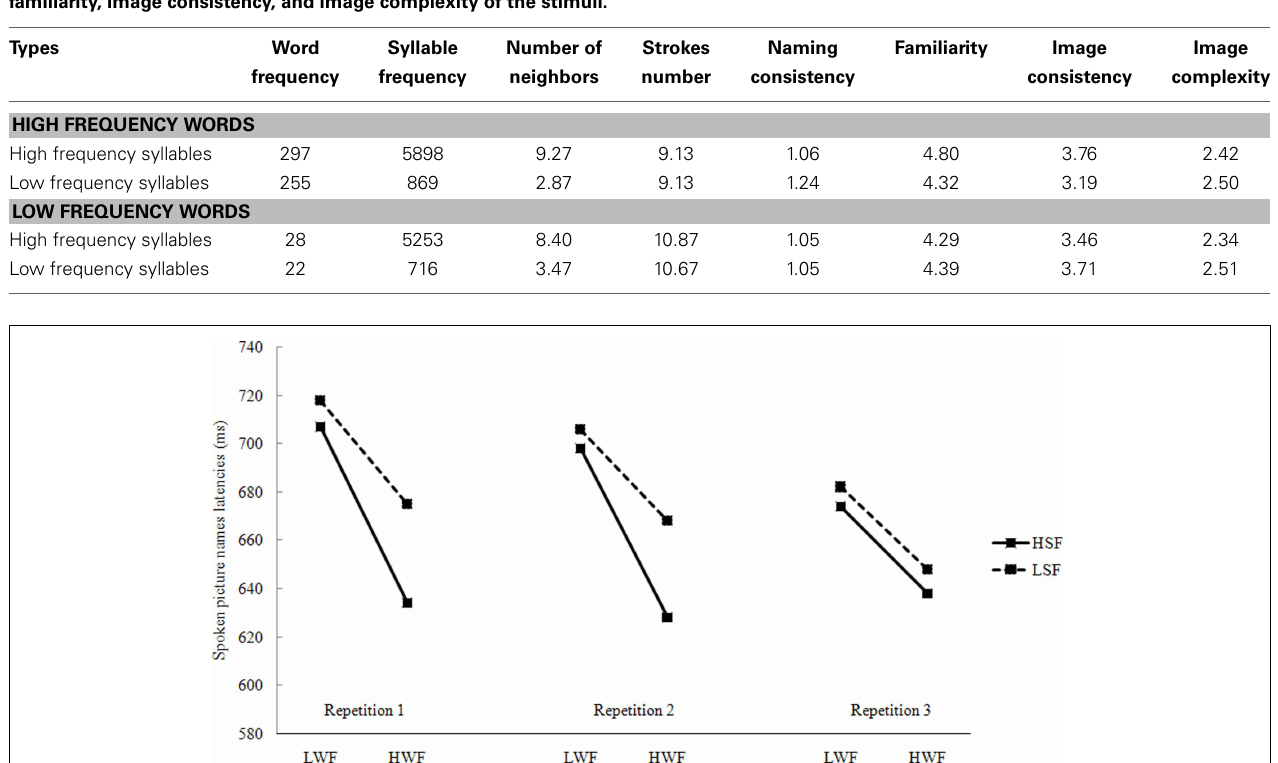
FIGURE 1 | Mean naming latencies in spoken responses by WF, SF, and repetitions (L, Low; H, High; WF, Word Frequency; SF, Syllable Frequency).